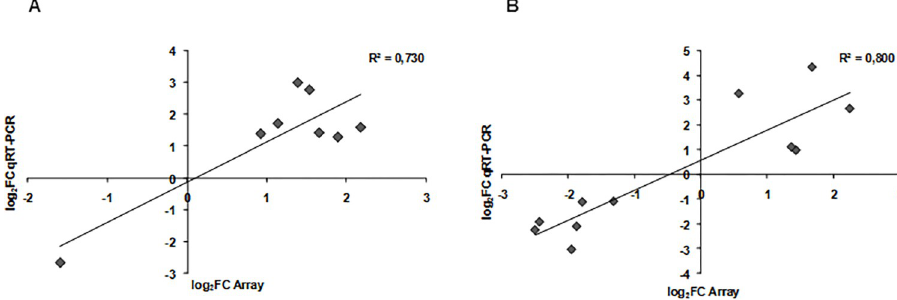
Fig 7. Correlation between average fold change in the expression of selected genes as predicted by microarray analysis and qRT-PCR. Genes up- and down-regulated by abatacept (A) and by anti-TNF α (B). Data are expressed as log 2